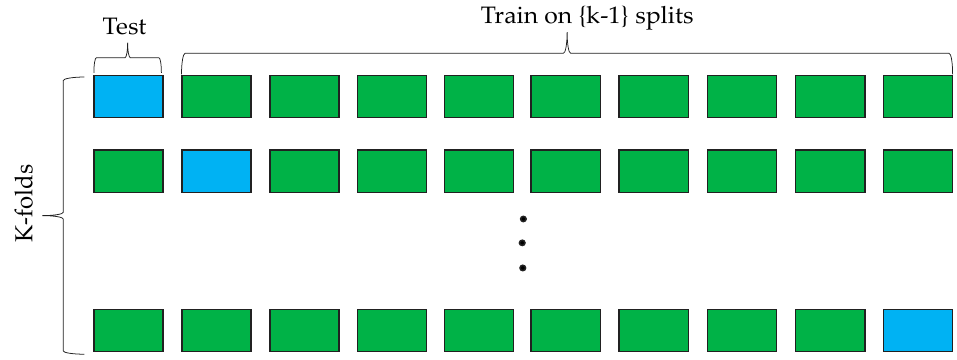
Figure 5. Illustration of k-fold cross-validation (CV) technique.